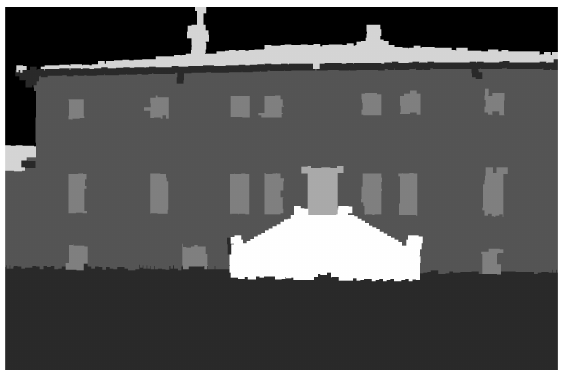
Figure 3. Example of labeled image of building in Figure 1.